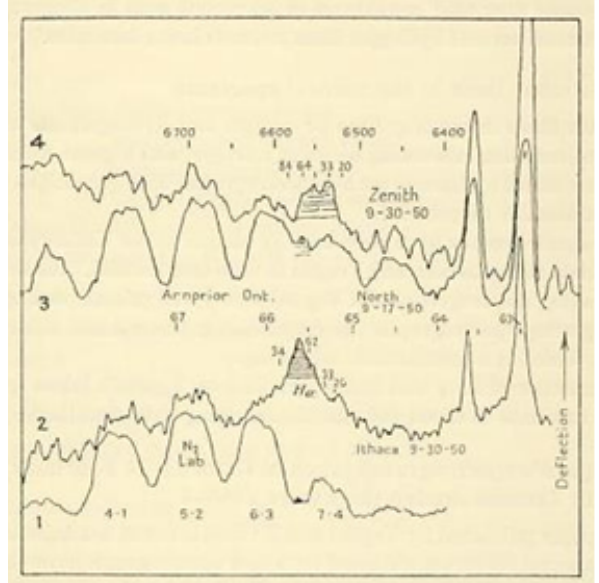
Figure 6. Example of violet shift and broadening of the H α line observed simultaneously from Ithaca, NY, and Arnprior, Ontario, during an auroral event on 30 September 1950 (Gartlein, 1951).